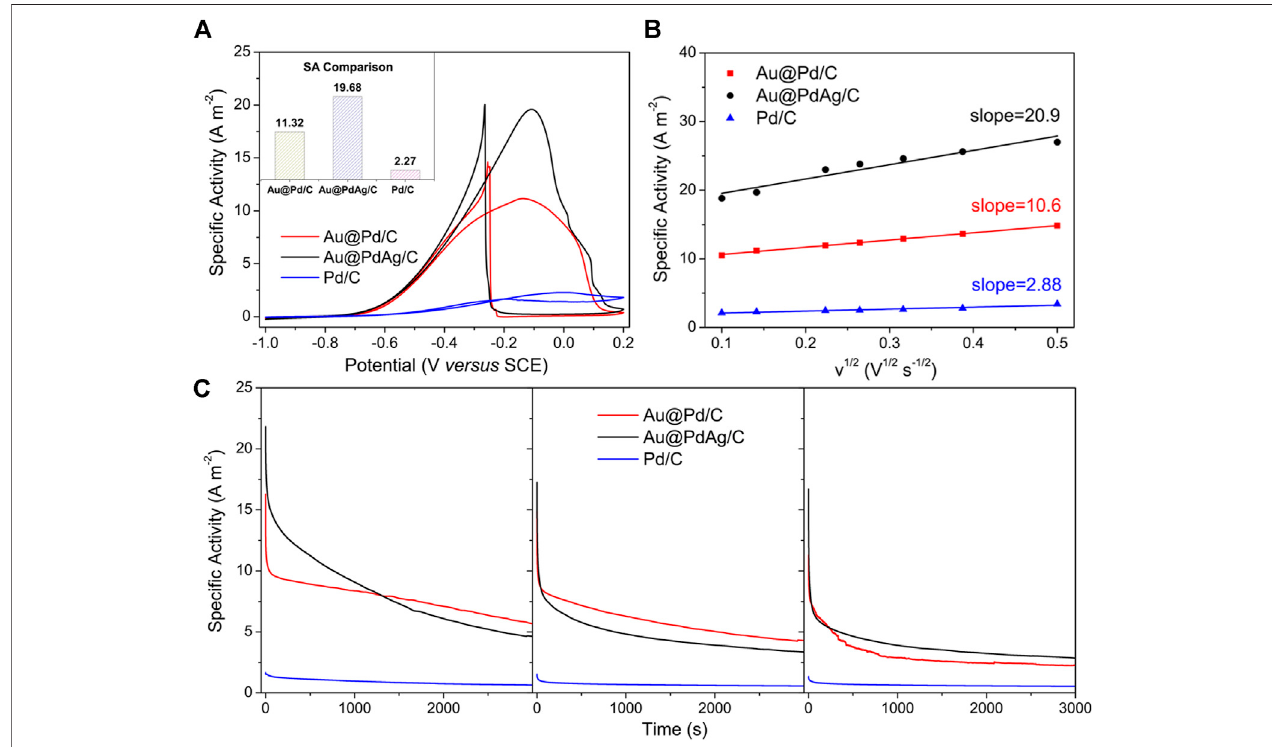
FIGURE 6 | Electrochemical measurements of carbon-supported Au@PdAg concave nanocubes (shell thickness: 12.5 nm, molar ratio: Au:Pd:Ag (cid:1) 40:44:16) electrocatalystsforEOR: (A) CVcurvesin1 Methanolcontaining1 MKOH; (B) EORkineticsbasedonspeci fi cactivityandscanrates; (C) Chronoamperometricstability curves measured at − 0.2 V vs. SCE. Data of carbon-supported Au@Pd nanoparticles and commercial Pd/C was provided as reference.